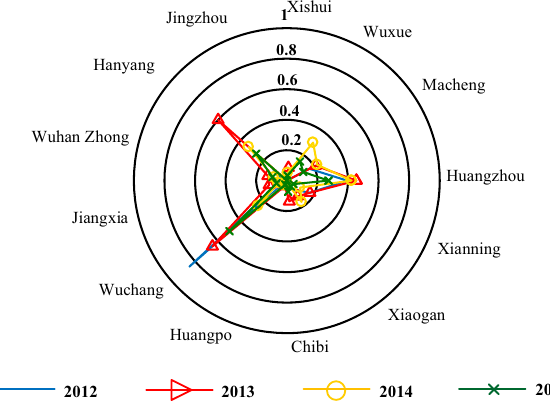
Fig. 2 CFF in central China regions in the period of